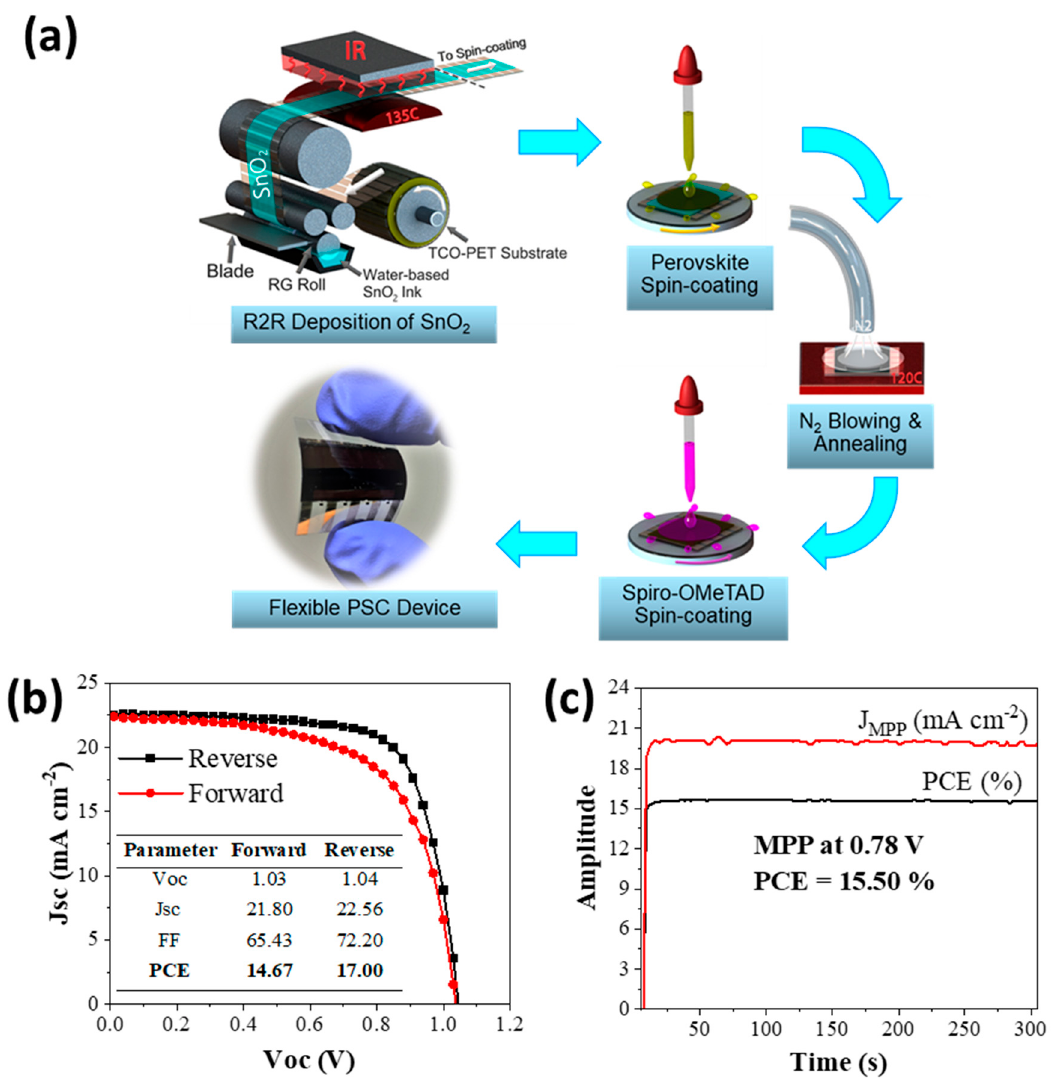
Figure 6. ( a ) Schematic representation of flexible PSC fabrication using R2R reverse-gravure coating of the ETL comprising synthesized SnO 2 , ( b ) J-V characteristics of the best-performing flexible PSC, ( c ) MPP tracking over time of the champion device.